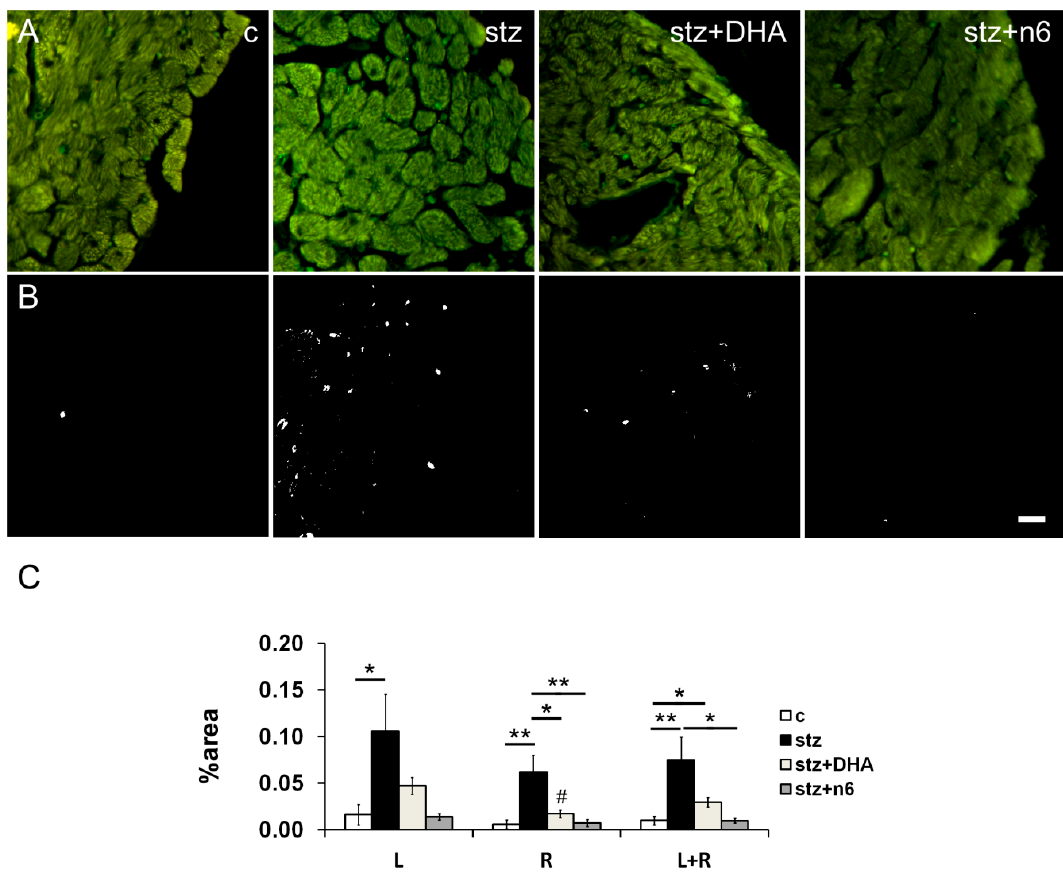
Figure 3. Neurofilament 200 immunoreactive nerve fiber density in subendocardial areas of cardiac septum. ( A ) Representative photomicrographs of right side of the subendocardial area of the cardiac septum stained for NF200, a marker for heavy myelinated sensory fibers (green). C—control group;